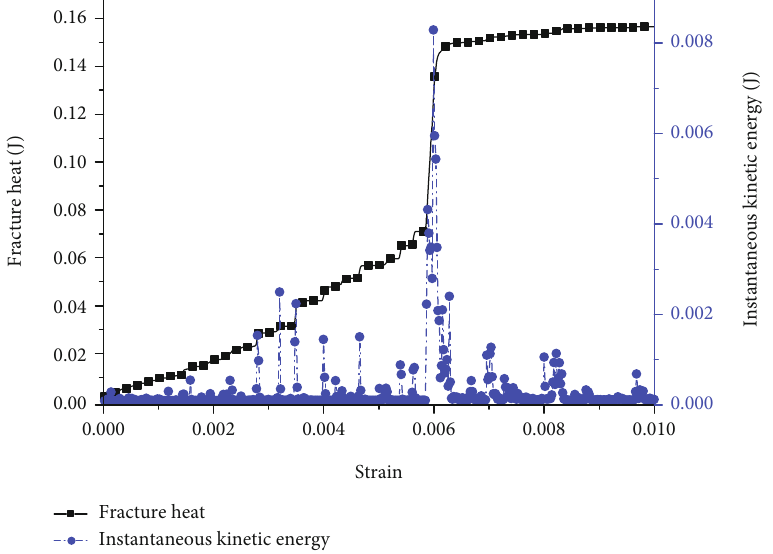
Figure 14: Change of fracture heat and instantaneous kinetic energy of gas-containing coal.